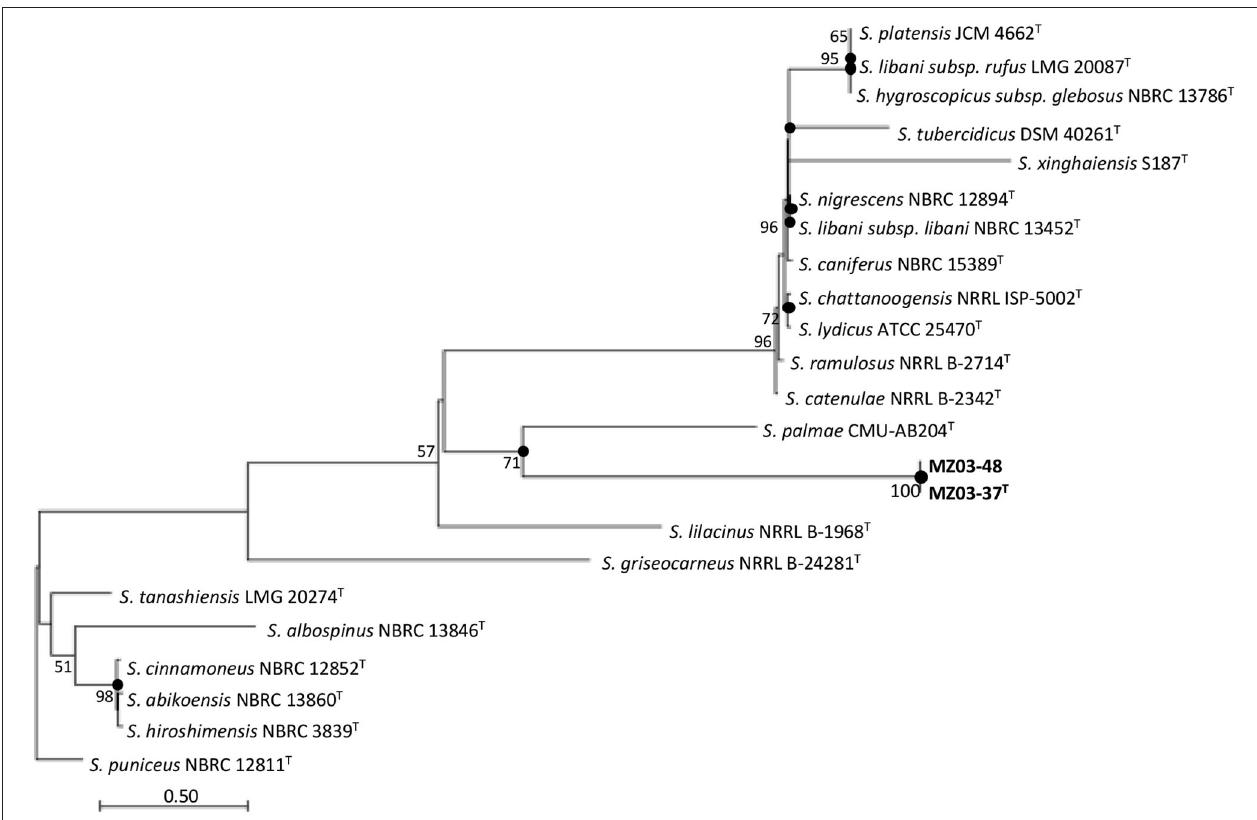
FIGURE 1 | Maximum-likelihood trees based on six-gene concatenated sequences (16S rRNA-atpD-gyrB-recA-rpoB-trpB) showing the relationship of strains MZ03-37T and MZ03-48 and other species of the genus Streptomyces . Bootstrap values (N50%) are expressed as percentages of 1,000 replicates. Closed circles show the nodes that were also recovered by the neighbor-joining and maximum-parsimony algorithms. Streptomyces puniceus NBRC 12811T was used as the outgroup. Bar, 0.50 substitutions per nucleotide